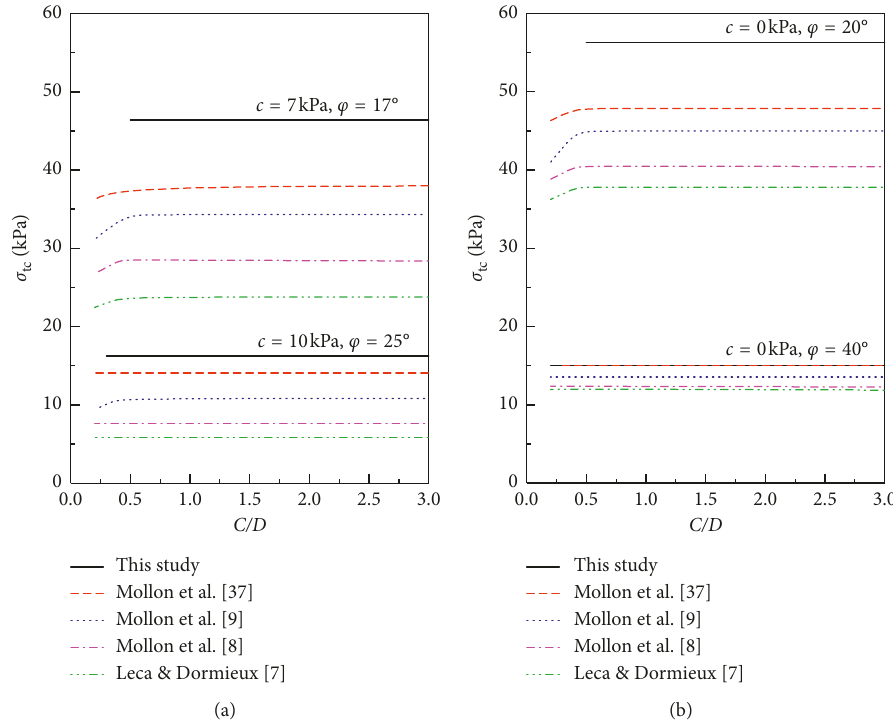
Figure 3: Comparisons of the critical results derived from different postulated mechanisms ( c Table 1: Comparisons of the obtained supported pressures (kPa) on the tunnel face for D